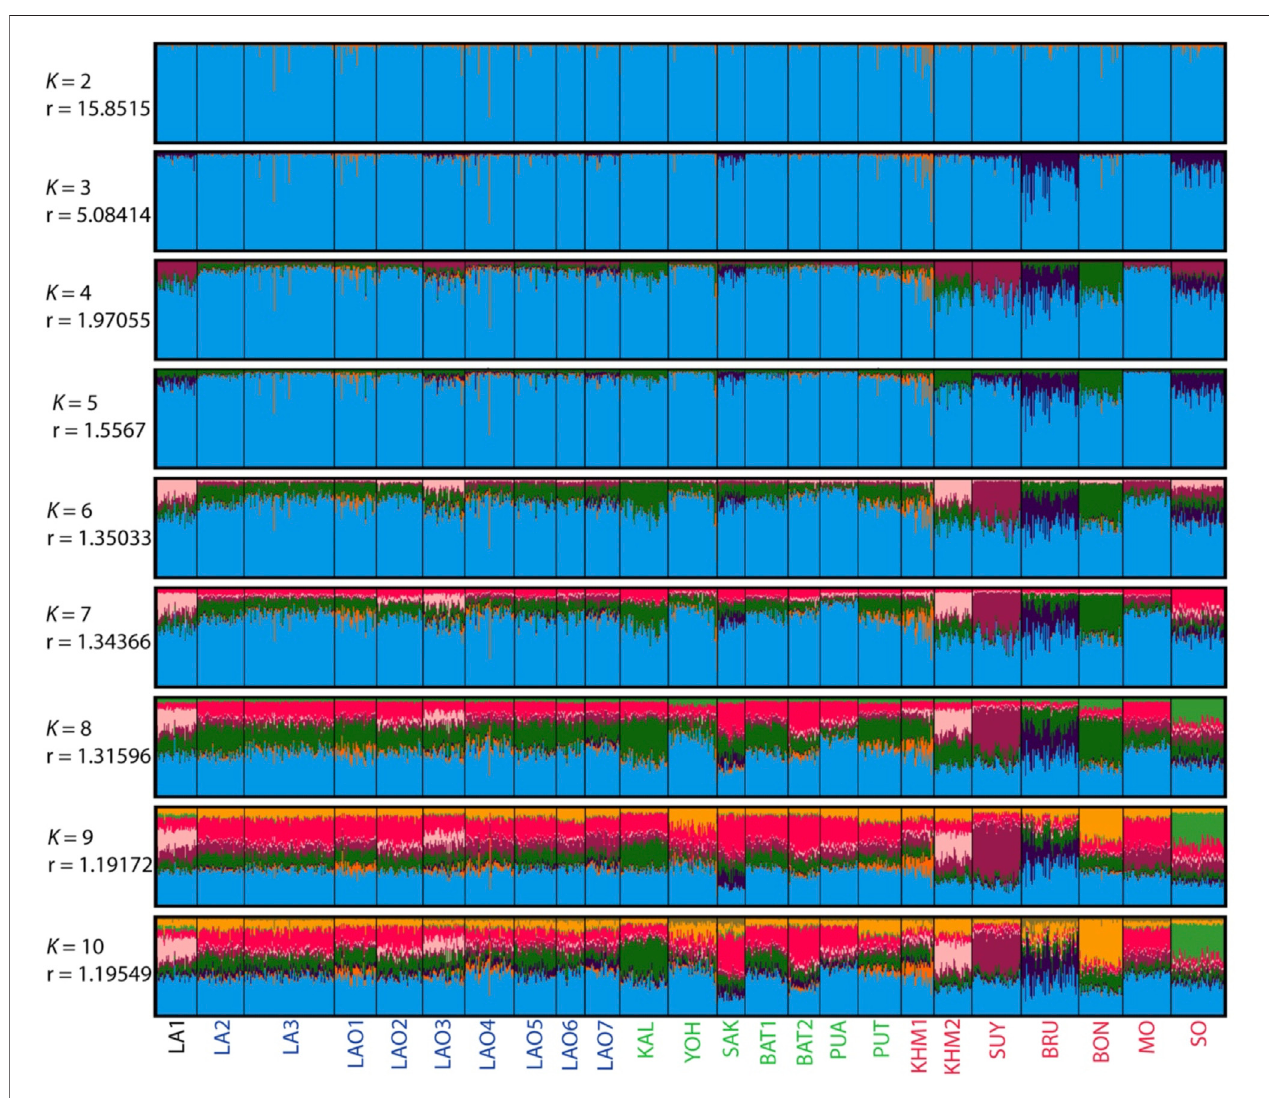
FIGURE7| TheSTRUCTUREresultof24populationsfromnumberofcluster( K )=2to10.Eachindividualpopulationisrepresentedbyasinglecolumndividedinto segments whose size and colour correspond to the relative proportion of a particular cluster. Populations are separated by black lines. Population names are color- coded; black, blue, green and red represent AA-speaking Laotian, ethnic Lao group, comparing TK-speaking and AA-speaking populations, respectively. The parameters “ r ” indicate the informativeness of sampling location data.